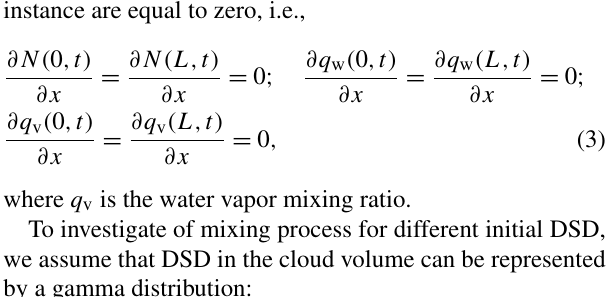
Figure 1. The initial state at t = 0. The left volume is a saturated cloudy volume; the right volume is an undersaturated dry air vol-